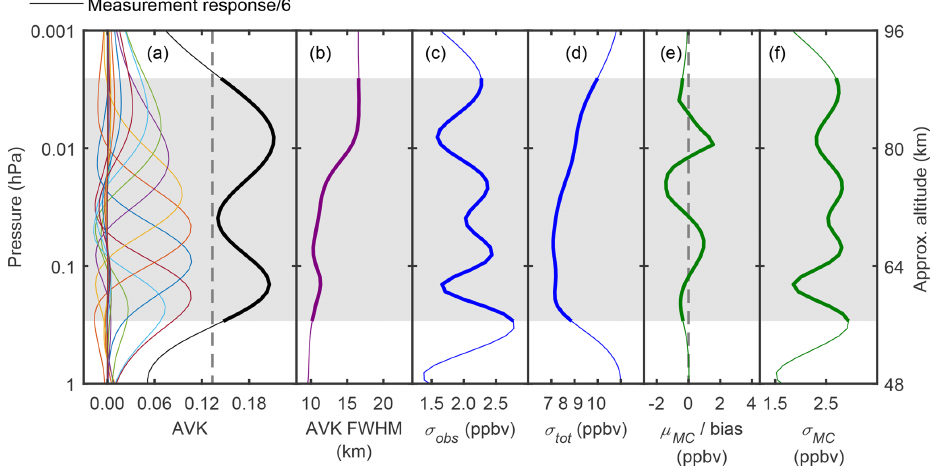
Figure 12. Hydroxyl (OH) retrieval diagnostics for simulated 6h observations of the OH 13.441GHz emission line using a ground-based radiometer with vertical polarisation, 1mK baseline noise level, 10kHz frequency resolution, 82 ◦ zenith angle, and 0 ◦ azimuthal angle (i.e. north-pointing) located at Kilpisjärvi (69 ◦ 03 (cid:48) N, 20 ◦ 48 (cid:48) E), Finland, in clear-sky December conditions. In (a) every sixth averaging kernel and the scaled measurement response (MR) are shown. Panel (b) shows the full-width half maxima of each averaging kernel (AVK FWHM). The measurement uncertainty ( σ obs ) and total uncertainty ( σ tot ) are shown in (c) and (d) respectively. The mean ( µ MC ) and standard deviation ( σ MC ) of the differences between the retrieved and true profiles from Monte Carlo (MC) error analysis using 500 repeat inversions are shown in (e) and (f) respectively. The vertical grey dashed line in (a) shows the cut-off for MR ≥ 0.8. The grey shaded regions and the thicker sections of the plotted curves indicate the pressure and altitude ranges where MR ≥